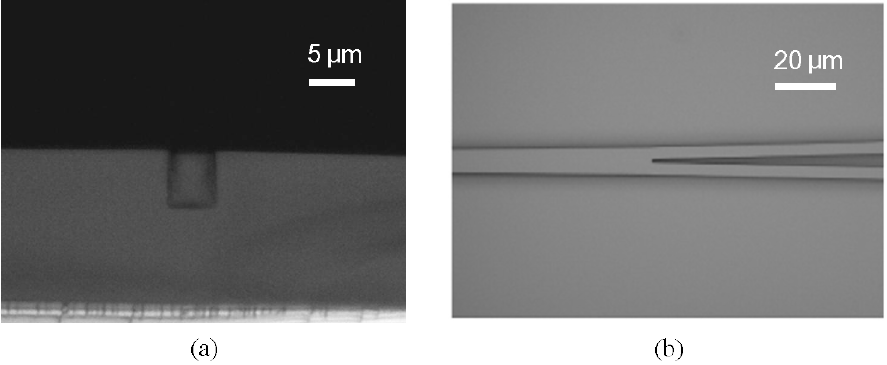
Figure 10. ( a ) Cross-section view showing rectangular core shape and no residual layer on the waveguide top; ( b ) the optical microscopic image of Y-junction area [50].